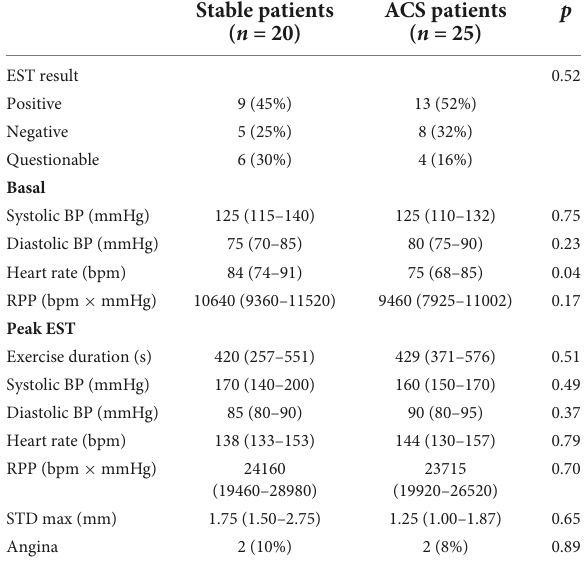
TABLE 1 Main characteristics of the two groups of patients. TABLE 2 Main exercise stress test